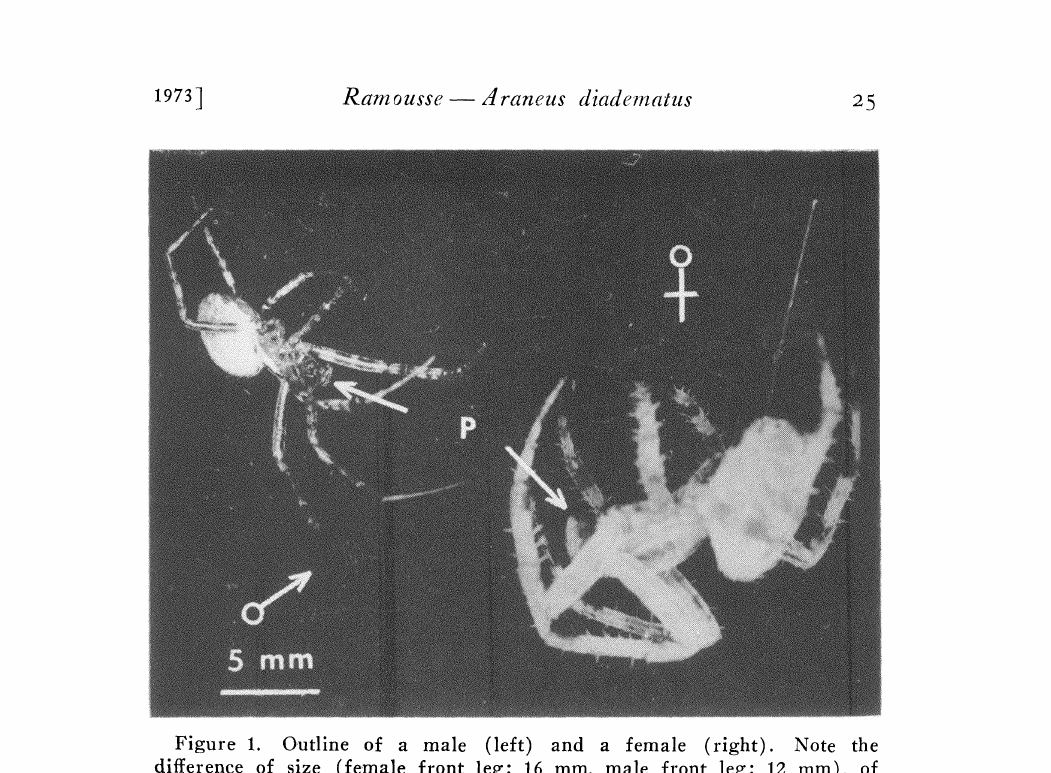
Figure 1. O.utline of a male (left) and a female (right). Note the difference of size (female front leg: 16 mm, male front leg: 12 ram), of weight (female" 144.1 mg, male" 47.0 mg) and the difference of form of the palps (short and enlarged for the male, long and thin for the